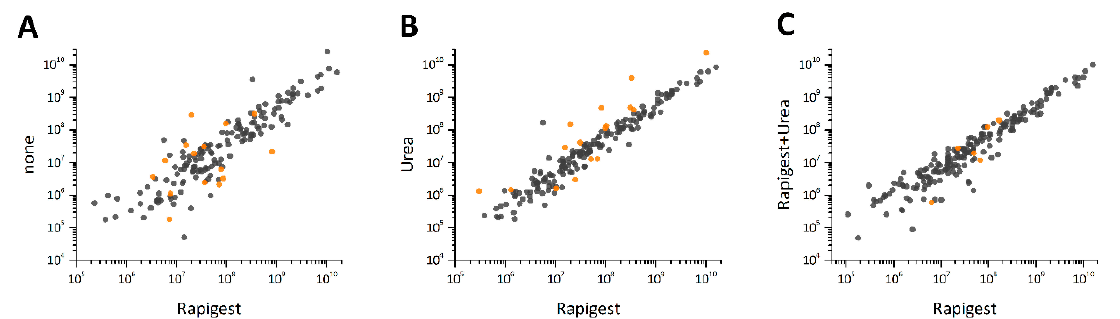
Figure 5. Pair-wise comparisons of protein abundances in SiO 2 NM corona depending on the solubilizing agent used, ( A ) Rapigest SF ™ treated versus untreated samples, ( B ) Rapigest SF ™ versus urea treated samples, ( C ) Rapigest SF ™ versus Rapigest SF ™ plus urea treated samples. Proteins labeled in orange show a statistically significant difference in abundance between the two experimental triplicates with a ratio of at least 2.